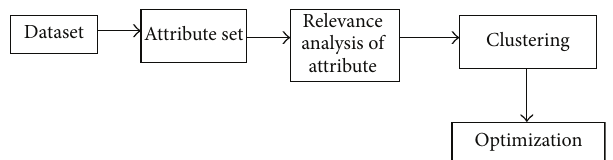
Figure 1: Block diagram of proposed